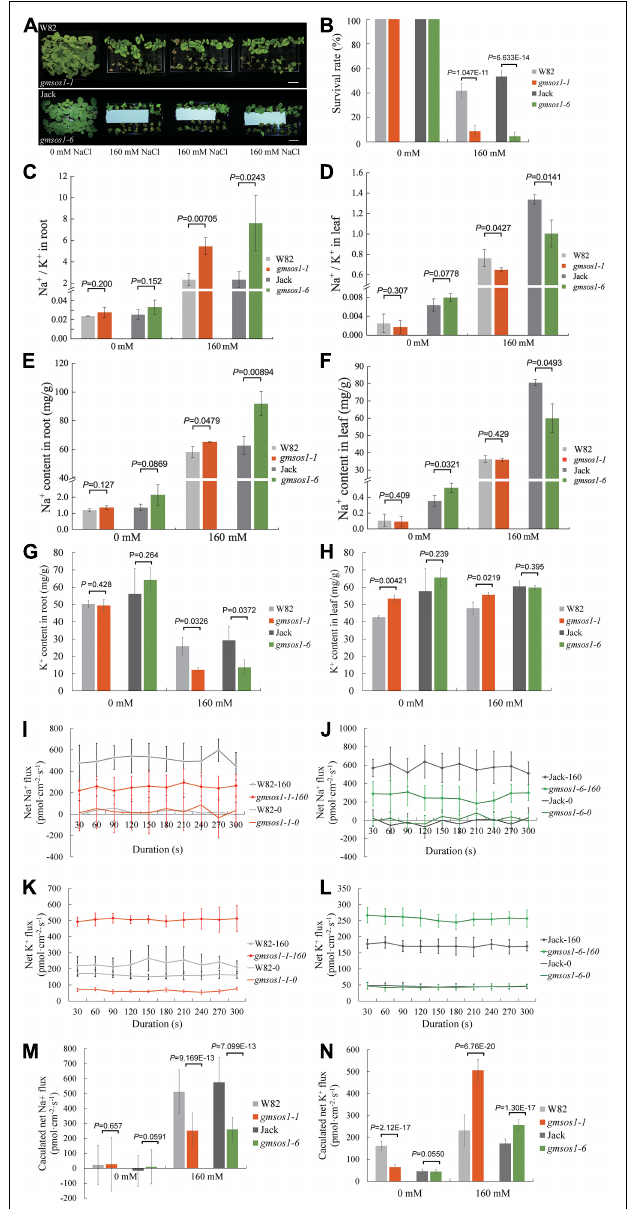
FIGURE 4 | The gmsos1 mutants are more sensitive to salt stress than wild-type plants. (A) Growth of the gmsos1 mutants and wild type plants in liquid medium containing 0 or 160 mM NaCl. Bar = 6 cm. (B) Survival rates of the gmsos1 mutants and wild-type plants as shown in (A) , the number of the plant is 12 in 3 repeated experiments. The Na + /K + ratios in roots (C) and in unifoliate leaves (D) , Na + content in roots (E) , Na + content in unifoliate leaves (F) , K + content in roots (G) , and K + content in unifoliate leaves (H) of plants as shown in (A) . Net Na + flux analysis at the meristem zones of wild type and gmsos1-1 (I) and gmsos1-6 (J) mutants. Net K + flux analysis at the root meristem zones of wild type and gmsos1-1 (K) and gmsos1-6 (L) mutant. (M) Calculated net Na + fluxes from Net Na + flux analysis at the meristem zone of wild-type and mutant roots. (N) Calculated net K + fluxes from Net K + flux analysis at the meristem zone of wild types and mutants. Data are means ± SD [ n = 3 in ( B , there are 12 plants per biological replicate), 6 in (C–N , there are at least 12 plants per biological replicate)]. p -values from Student’s t -tests were added in (B)–(H) , (M) , and (N) .